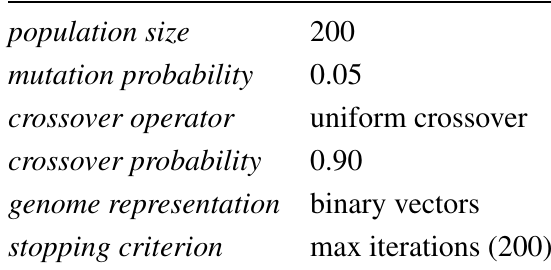
Table 1. Algorithm Parameters: Parameters used for the Modified Extinction Evolutionary Algorithm